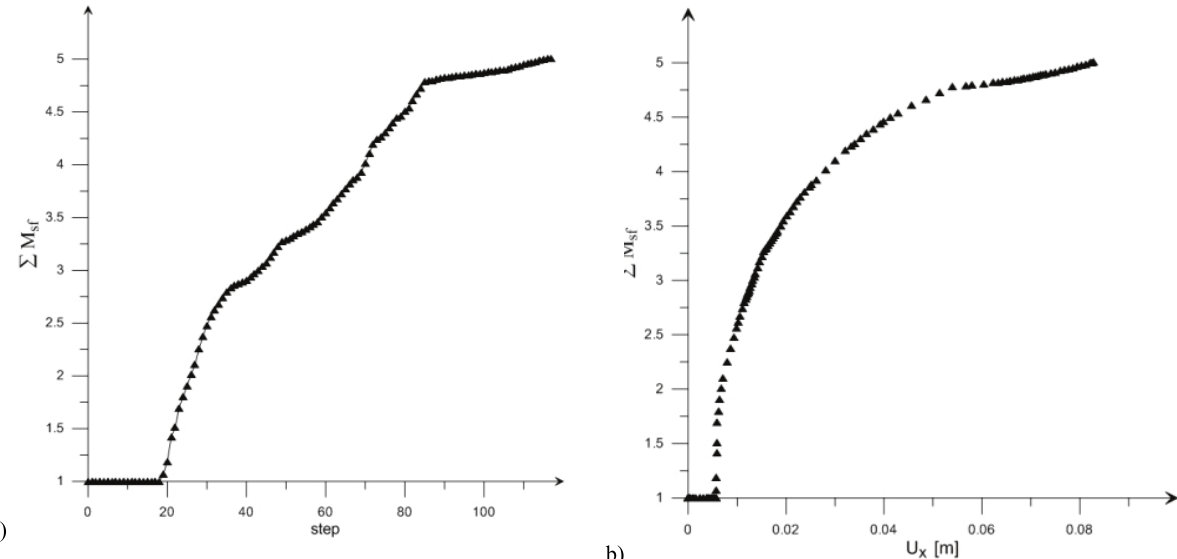
Fig. 13. ∑ M sf calculation versus: (a) step, (b) u x displacements